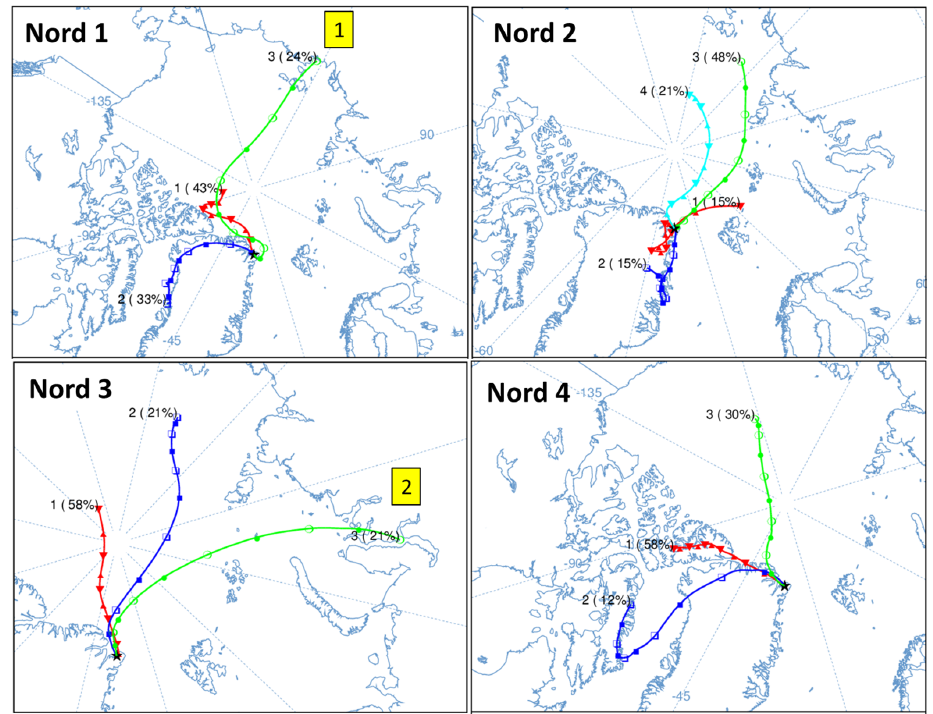
Figure 5. Five-day backward air trajectories ending at Station Nord at 10m height above ground level, calculated using the HYSPLIT model. Backward air trajectories were made for every fourth hour and clustered for each sampling week of 2010 (each coloured trajectory represents a cluster mean). Sampling weeks with similar trajectory patterns are represented by one map in the following manner: Nord 1 week 4; Nord 2 weeks 8, 24, 44 and 48; Nord 3 week 12; and Nord 4 weeks 16, 20 and 32–40. The 1 marks the location of the Yakutsk area and the 2 marks the location of the Norilsk area, two anthropogenic source regions contributing to air pollution in the Arctic (Ottar, 1989; Pacyna et al.,